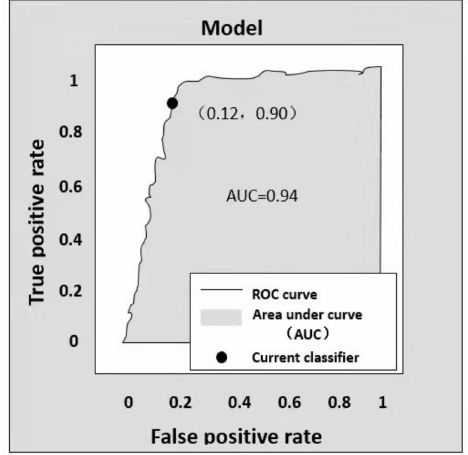
Figure 12. Diagram of ROC curve and